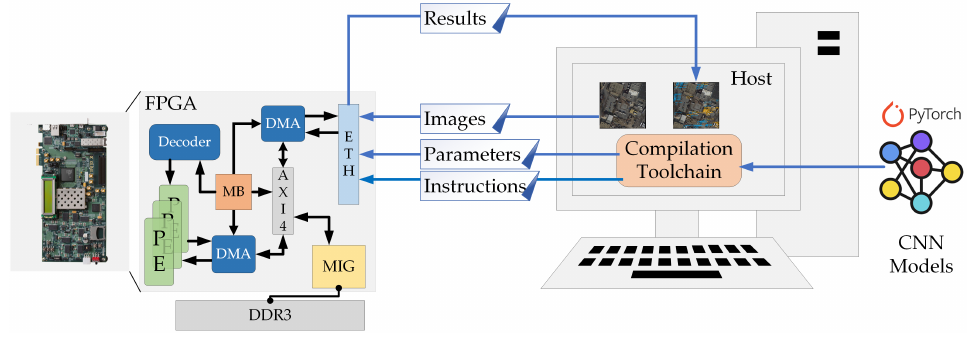
Figure 19. Experimental environment.